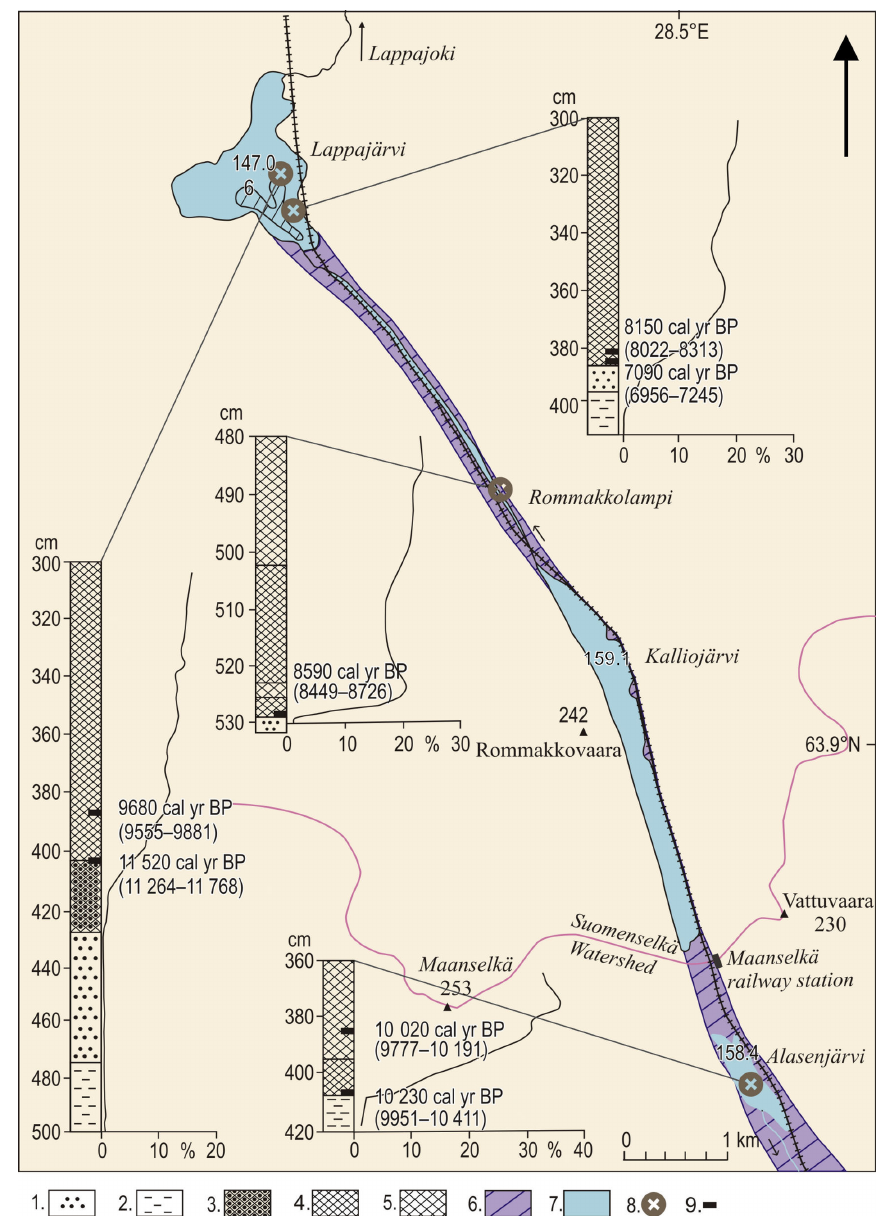
Fig. 3. The northwestern drainage channel (Kallioj(cid:228)rvi channel) and the lithologies of the sampling sites. 1, Sand; 2, clay of the ice-dammed lake; 3, gyttja clay; 4, clay gyttja; 5, gyttja; 6, ancient northwestern outlet; 7, present watercourses; 8, sample site; 9, AMS